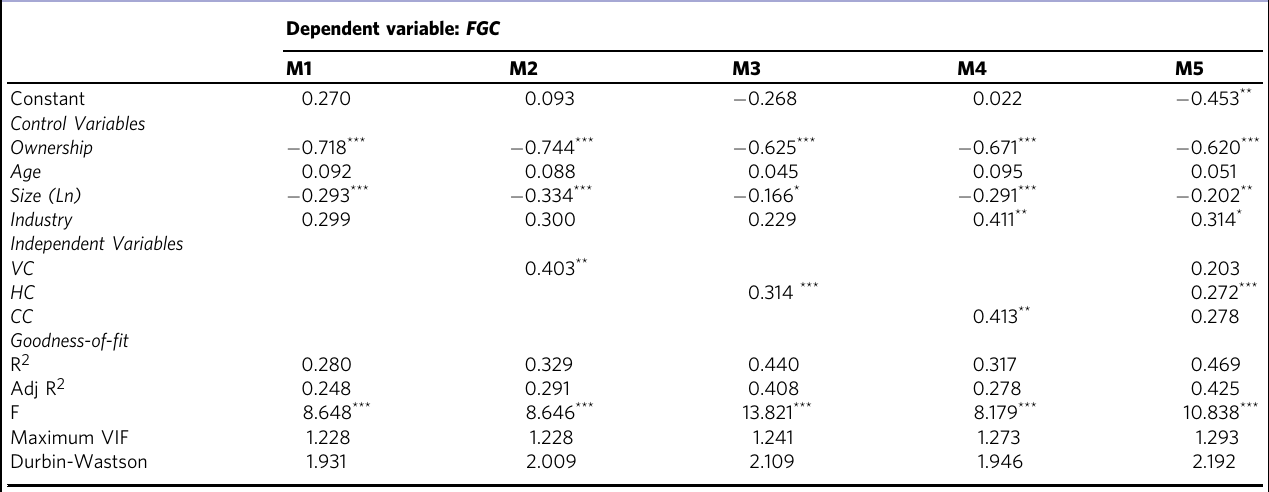
Table 3 The effects of external collaboration on fi rm growth